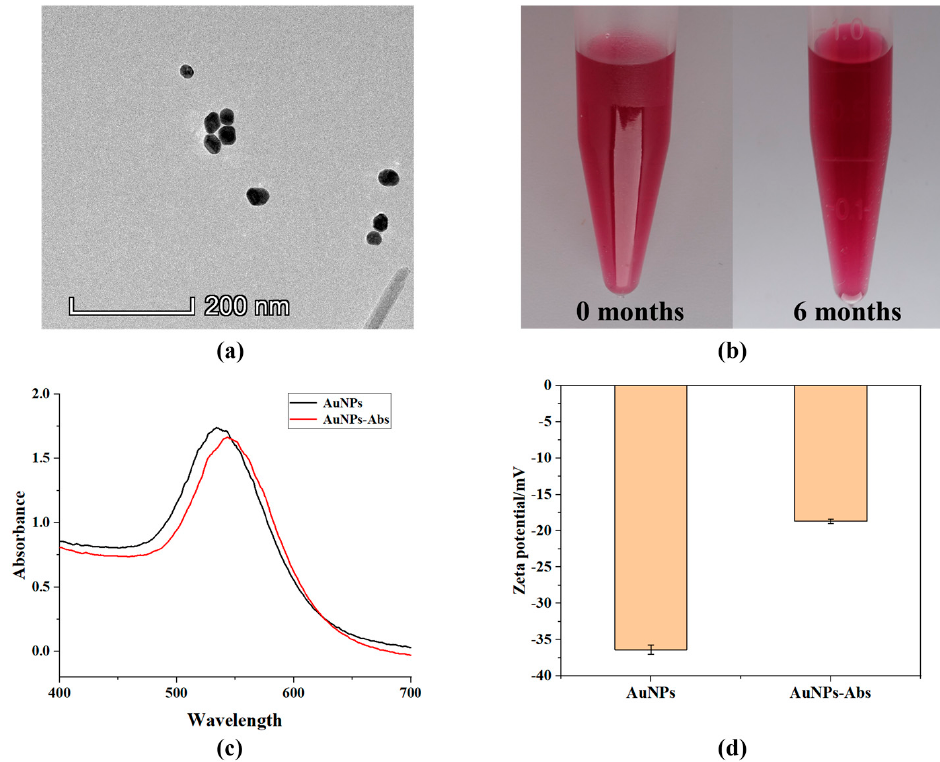
Figure 2. Characterization of Au nanoparticles (AuNPs) and Au nanoparticles-antibodies (AuNPs– Abs). ( a ) Transmission electron microscopy images of AuNPs; ( b ) the results of naked-eye observation of AuNPs at different times; ( c ) the UV–visible absorption spectra of AuNPs and AuNPs–Abs; ( d ) the zeta potential of AuNPs and AuNPs–Abs.